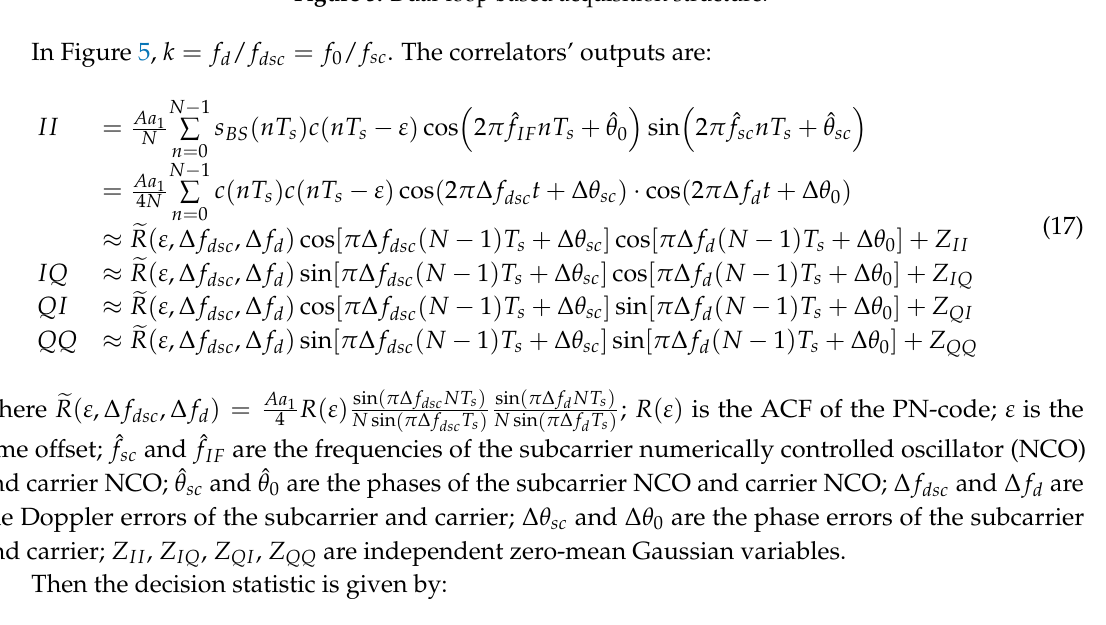
Figure 5. Dual-loop based acquisition structure.